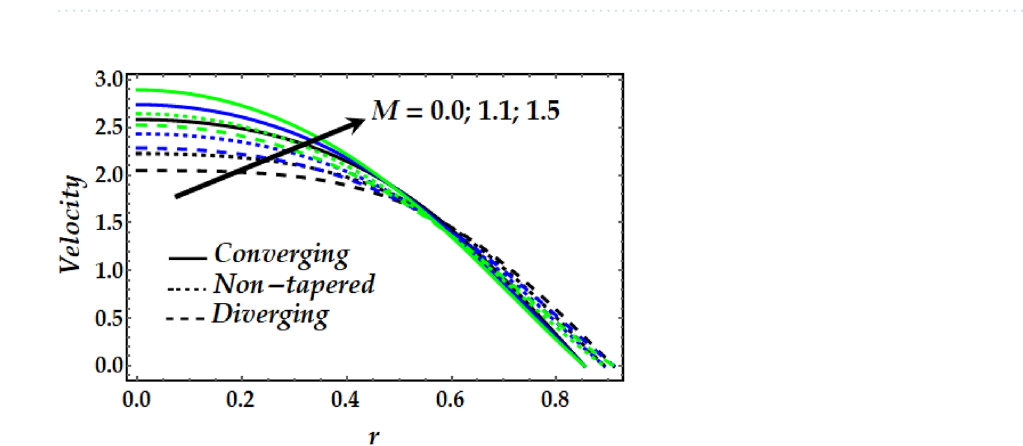
Figure 3. Velocity profile against distinct values of ζ .